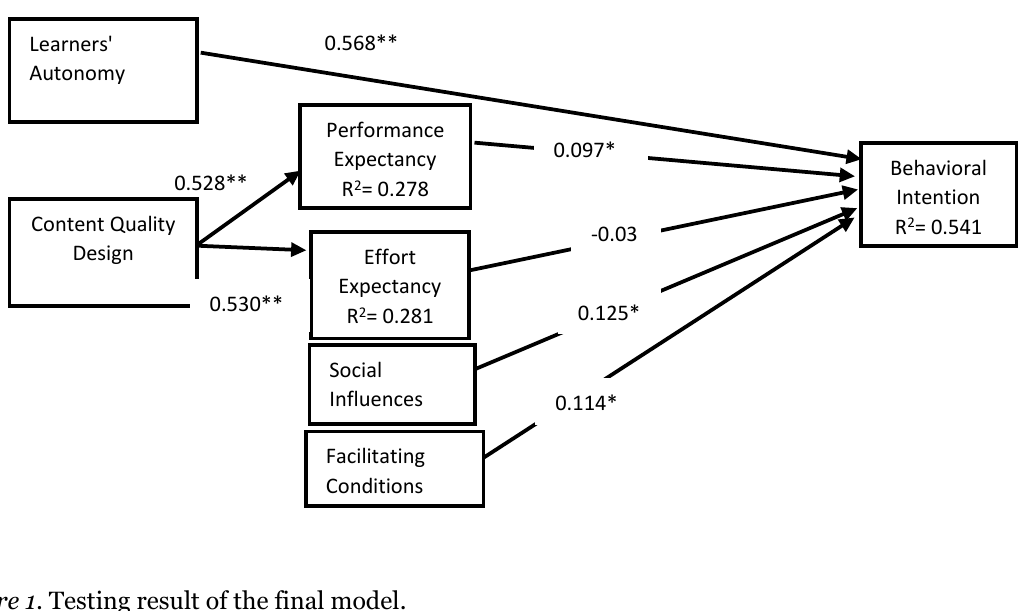
Figure 1. Testing result of the final model. Note. * P < 0.05, ** P <